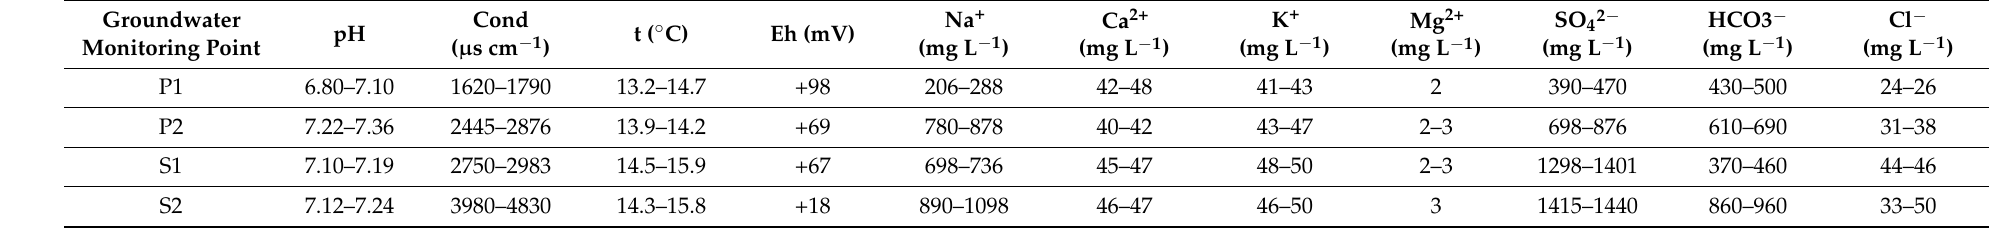
Table 1. Minimum and maximum values detected from July 2015 to September 2015 (fortnightly sampling activities for a total of 7 campaigns) for physical–chemical parameters (pH, electrical conductivity (EC), temperature, Eh) and main chemicals (Na + , Ca 2+ , K + , Mg 2+ , SO4 2 − , HCO 3 − , and Cl − ) in groundwater monitoring points from the source area (earthslide) of the Vedriano